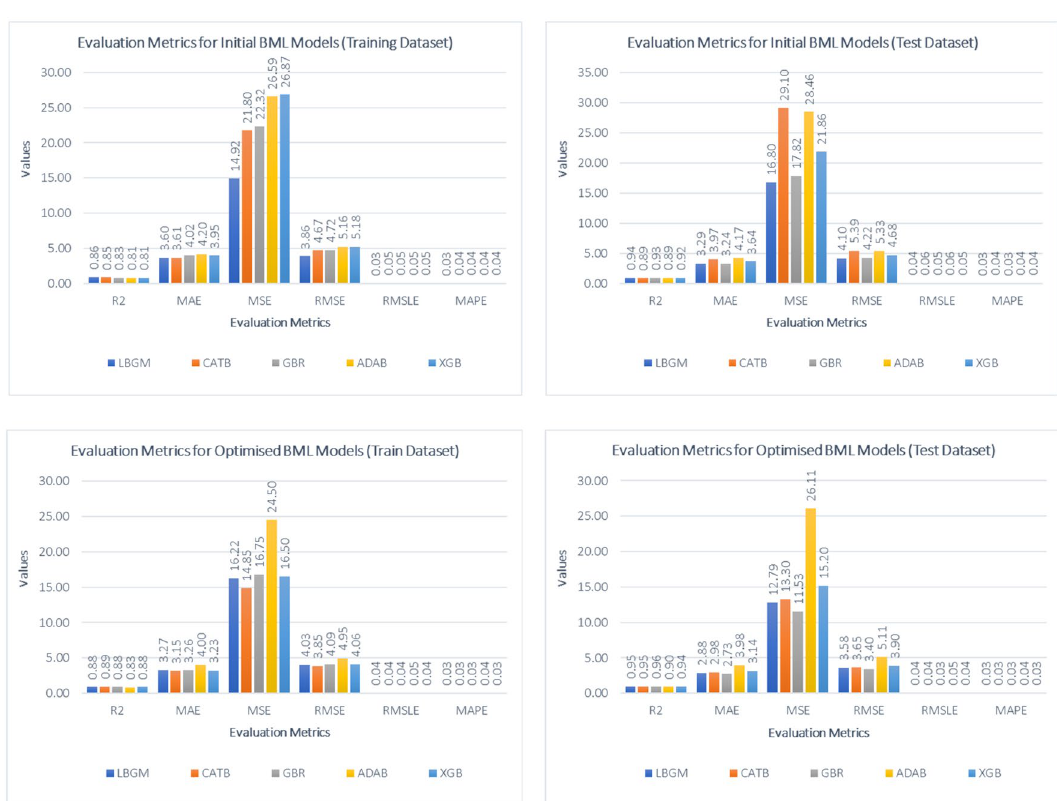
Figure 8. Comparison between BML and RS optimised